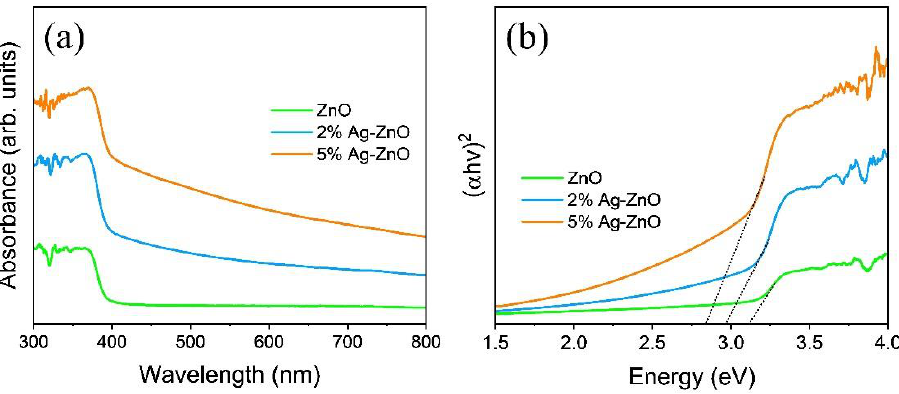
Figure 4. ( a ) UV-visible absorption spectra, and ( b ) Tauc plot of the pure ZnO and Ag-ZnO.